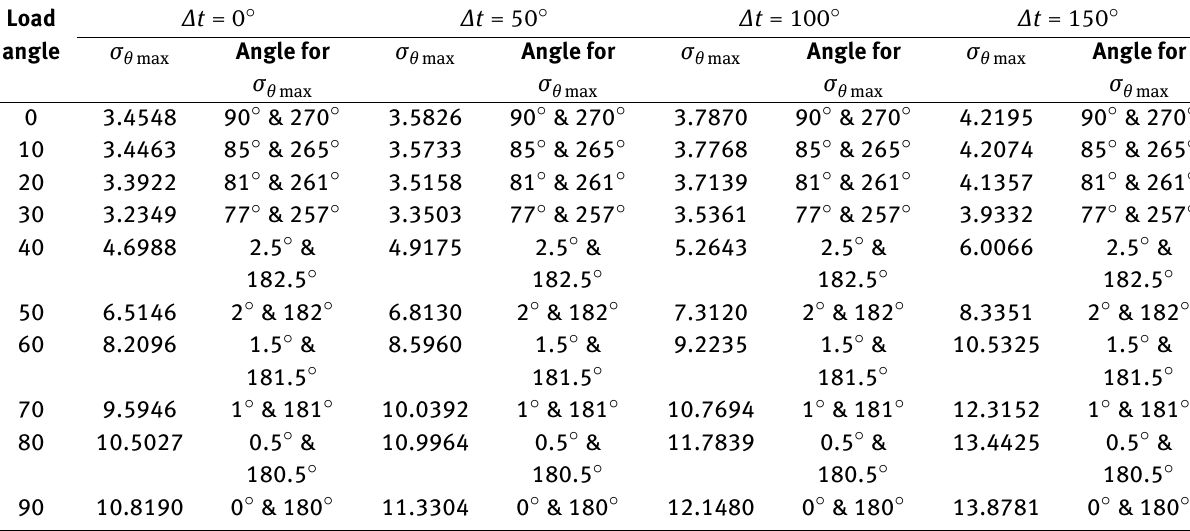
Figure 8: Effect of ∆t on σ θ max around elliptical hole in orthotropic plate for different in plane loadings (a) Cross ply [0/90]s (b) Angle ply [45/ − 45]s Table 3: Effect of ∆t and load angle on σ θmax (a/b = 2, Load angle variation from 0 ∘ to 90 ∘ axis,